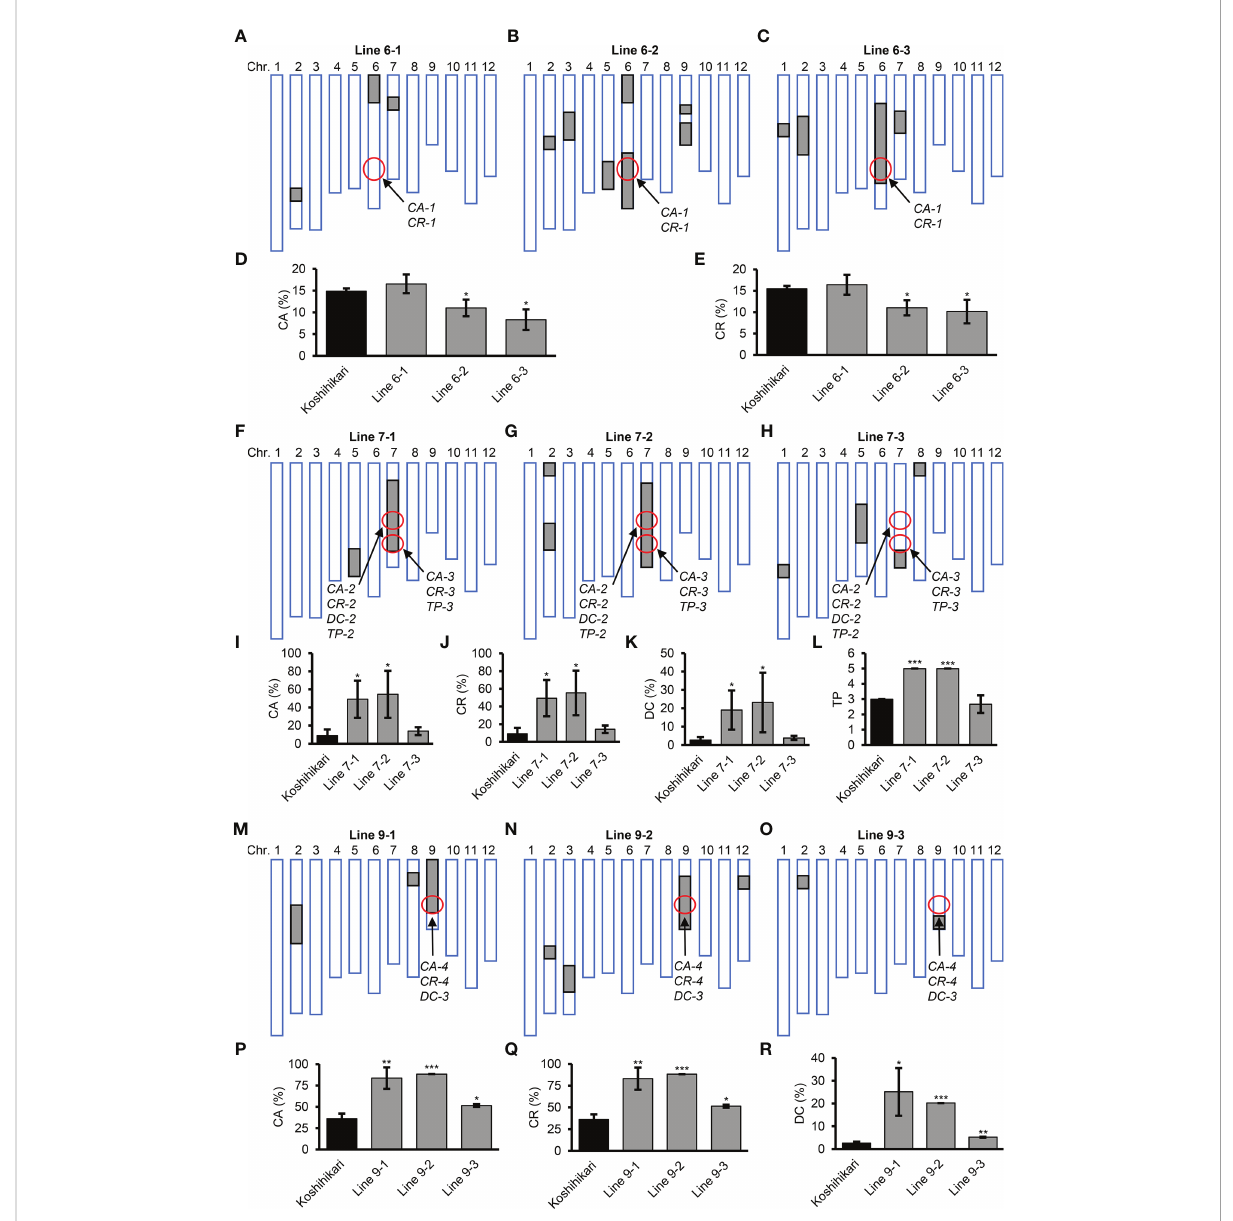
FIGURE 7 Grain quality traits of chromosome segment substitution lines. (A − C, F − H, M − O) Diagrams showing the genotypes of nine CSSLs. White boxes represent homozygous segments from Koshihikari; gray boxes represent homozygous segments from Nona Bokra; the positions of the indicated QTLs are circled. (D, E, I − L, P − R) Grain quality traits of CSSLs. CA, percentage of chalkiness area; CR, percentage of chalky rice; DC, degree of chalkiness; TP, transparency. Results are mean ± SD of three biological replicates. * p < 0.05, ** p < 0.01, *** p < 0.001, Student ’ s t